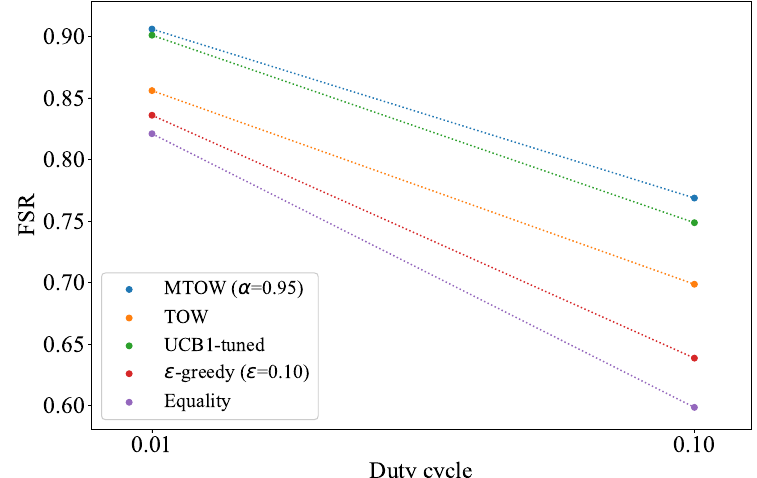
Figure 8. Duty cycle vs. FSR in the IoT network where there are 10,000 nodes and 30 available channels, while 12 channels may be loaded by the IoT devices of the other kind of network with a communication frequency of λ = 0.8 and a duty ratio of 0.5.